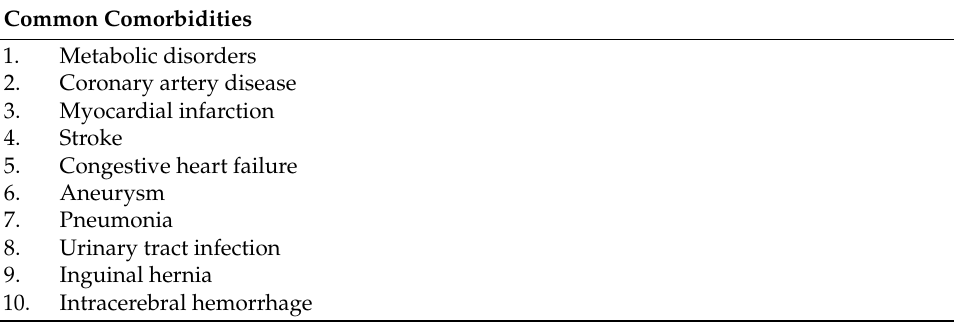
Table 2. Most common comorbidities with T2DM and HTN.